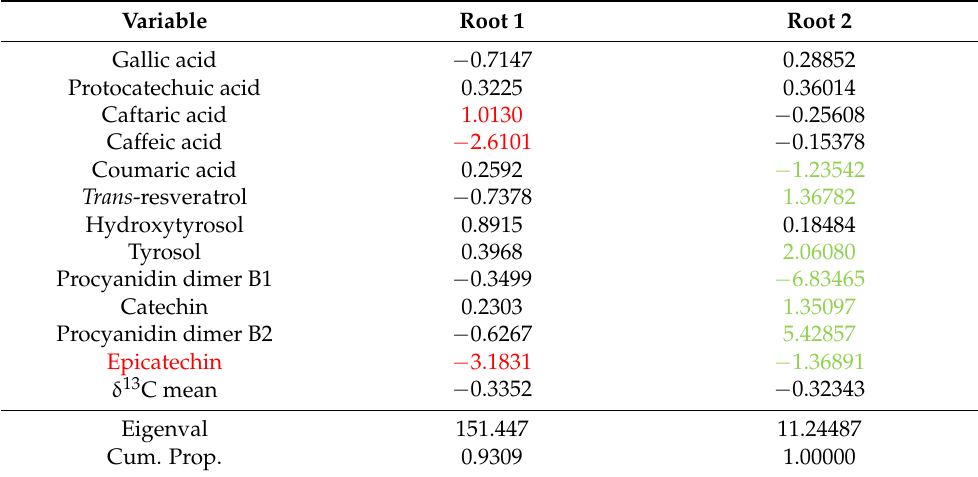
Table 9. Standardized coefficients for canonical variables.